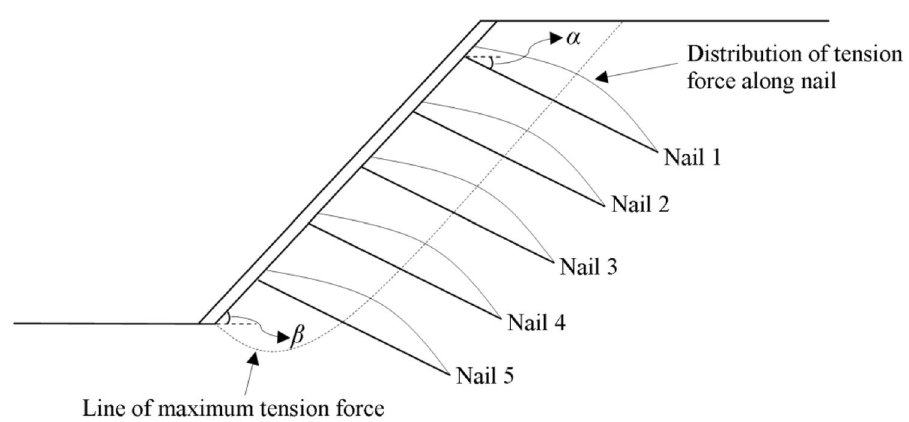
Fig. 5 The geometry of the nail model and distribution of ten- sion force along the